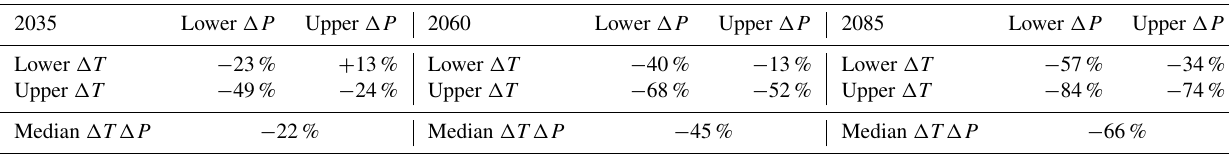
Table 3. Change (%) in snow depth relative to the reference period for the three future time periods based on the A2 emission scenario in the Aare